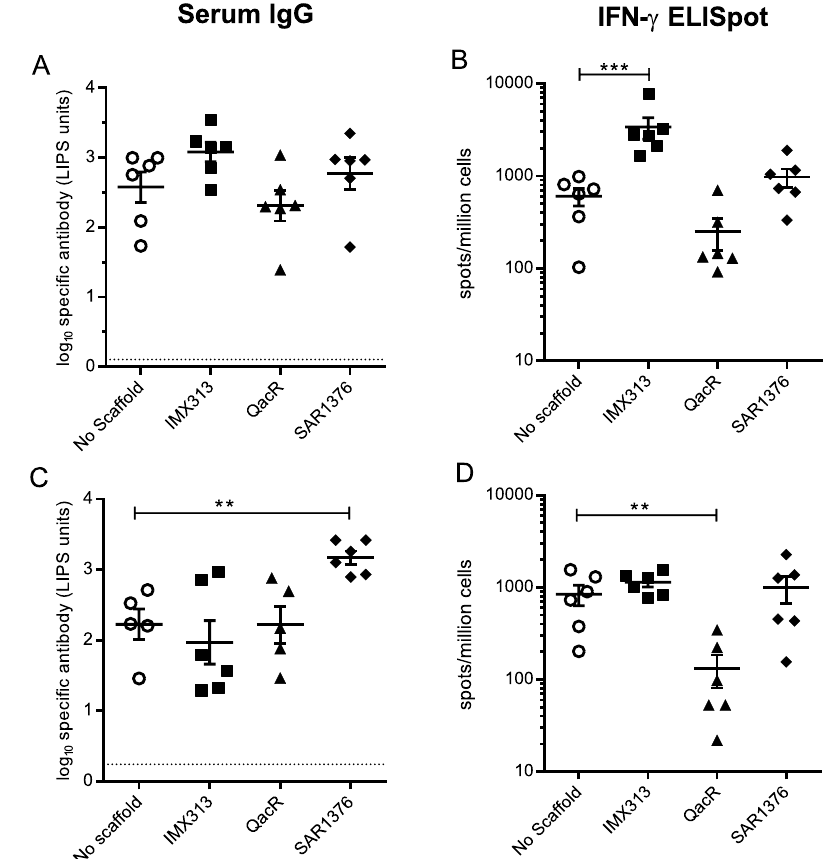
Figure 3. SAR1376 scaffold enhances immune responses to BitC and ClfB in BALB/c mice. Immunogenicity was assessed following prime-boost vaccination with DNA constructs encoding different scaffolds (as indicated on the X axes) fused to the antigen C-terminus; antigen specific IgG responses against BitC (panel A) and ClfB (panel C) measured by LIPS assay, and number of IFN- γ producing T-cells induced by BitC (panel B) and ClfB (panel D) at week 3 post boost. Each symbol represents a single mouse. Dotted line: threshold for background response. ** p < 0.01, *** p <